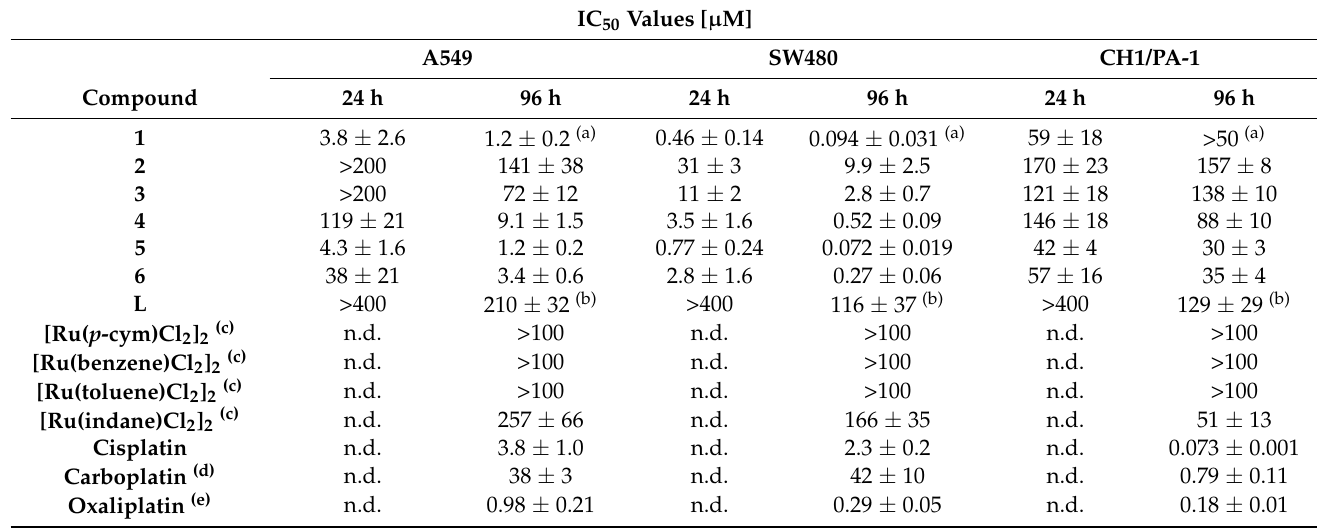
Table 3. Cytotoxicity of compounds ( L , 1 – 6 ), 50% inhibitory concentrations in human carcinoma cell lines A549, SW480 and CH1/PA-1. Values are means ± SDs obtained by the MTT assay (exposure time: 24 h and 96 h), n.d. = not